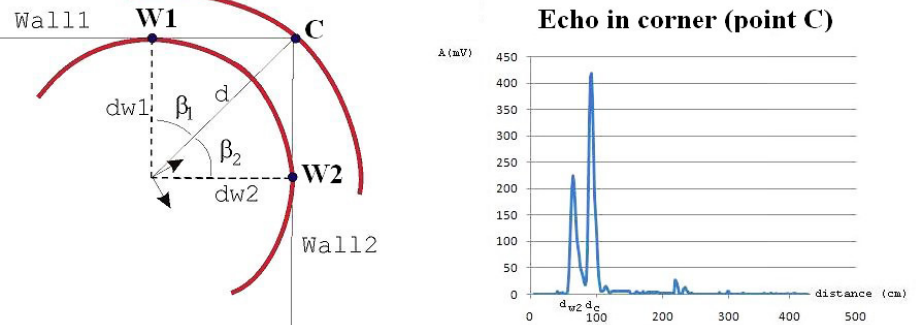
Figure 6. Transducer placed in the bisector of the corner. Echoes of the walls overlap at the same distance, appearing only one “ghost peak” before the corner’s peak.